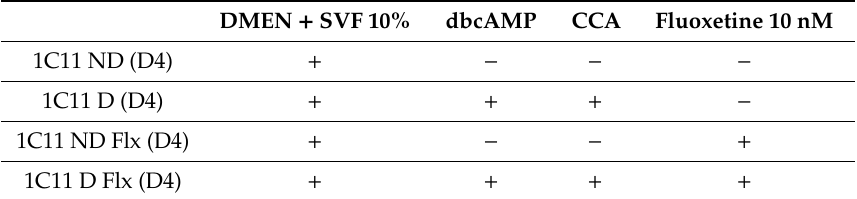
Table 1. Cells Treatment